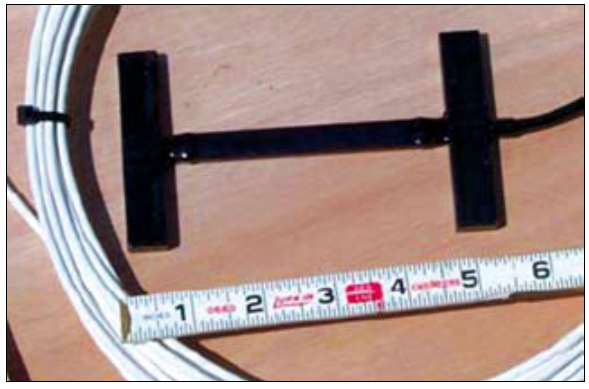
fig. 2. Strain transducer installed in experimental pavement structures